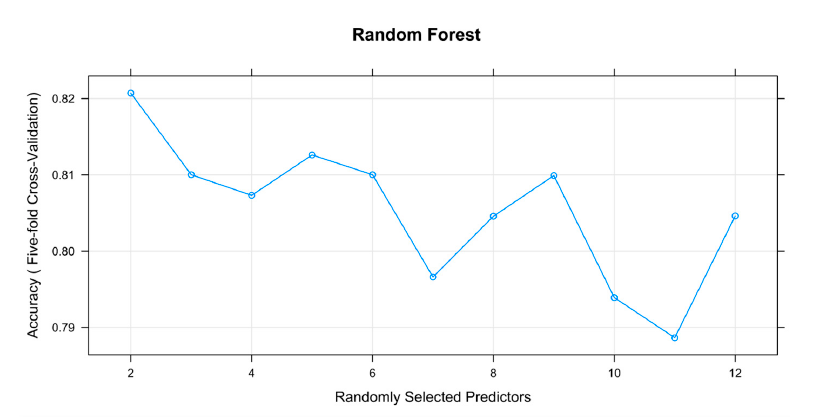
Figure 7. The accuracy cross-validation profile for a Random Forest model applied the meteorological dataset. The optimal number of predictors is 2. Appl. Sci. 2019 , 9 , x FOR PEER REVIEW